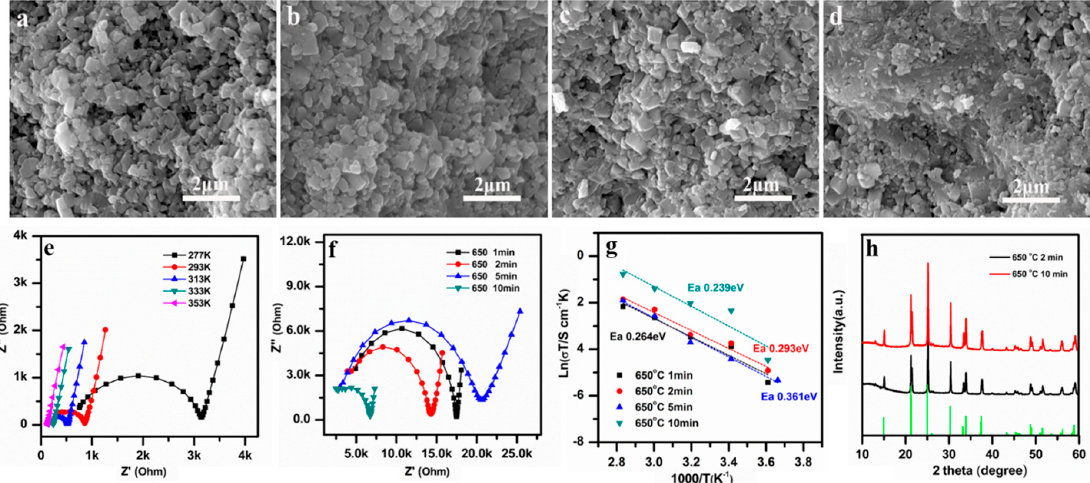
Figure 3. SEM images at cross sections of the LAGP pellets sintered at 650 °C for different sintering times: ( a ) 1 min, ( b ) 2 min, ( c ) 5 min, and ( d ) 10 min; ( e ) Nyquist plots of LAGP pellets (650 °C, 10 min) measured at different temperatures; ( f ) Nyquist plots, ( g ) Arrhenius plots, and ( h ) XRD patterns of the LAGP fabricated at 650 °C for 2 min and 10